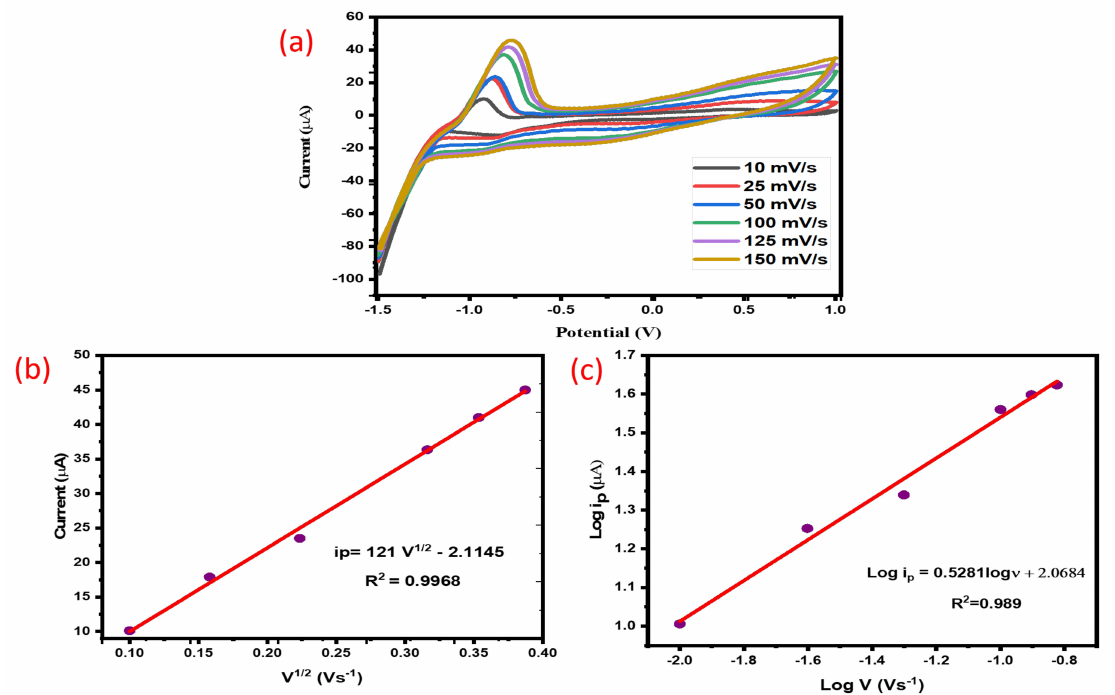
Figure 8. ( a ) Cyclic voltametric response of PANI@Al-SA/nafion modified GCE toward 0.065 mM Zn 2+ at different scan rate. ( b ) Plot of current peak against square root of scan rate. ( c ) Plot of log of peak current against log scan